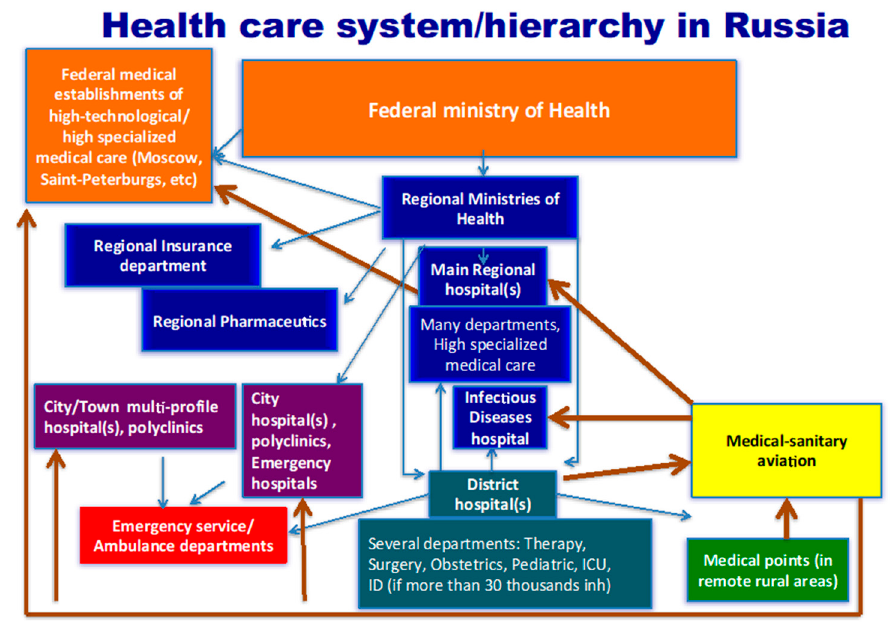
Figure 3. Health care system/hierarchy in Russia.